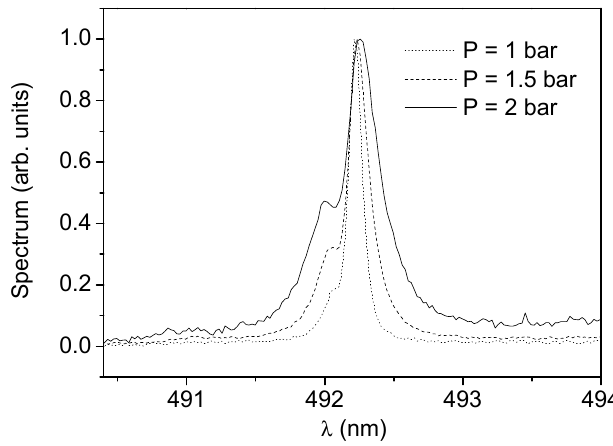
Figure 1. Plot of the helium 492 nm line observed in a helium corona discharge at room temperature, for different pressure values. The line width increases with the pressure. This trend is also observed on other lines. The bump on the blue wing denotes a forbidden transition induced by the microfield.